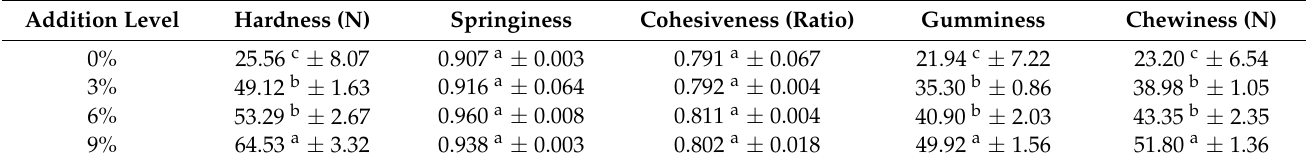
Table 1. Effect of the pea protein addition level (0%, 3%, 6% and 9%) on the hardness, springiness, cohesiveness, gumminess and chewiness of the duck meat batters.